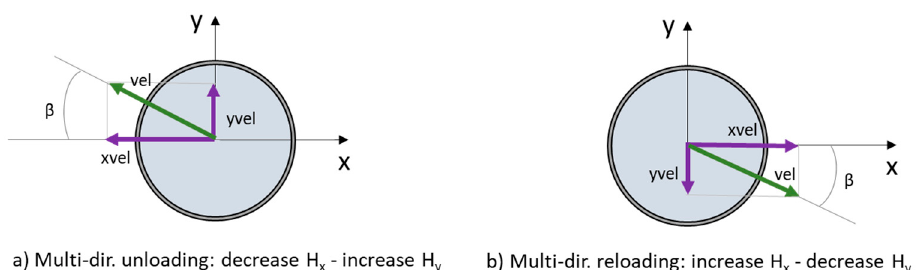
Figure 9. Nodal velocity applied on the pile head for multi-directional ( a ) unloading; and ( b ) reloading.